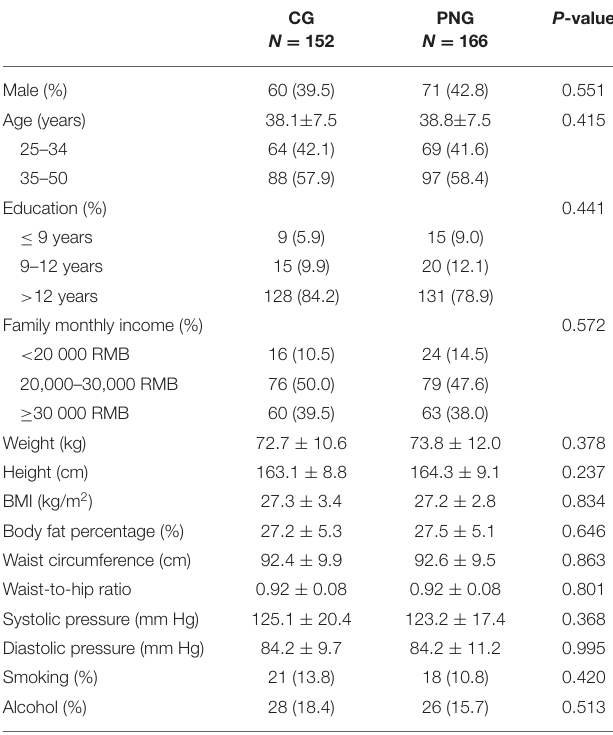
TABLE 1 | Baseline characteristics of the subjects who completed the